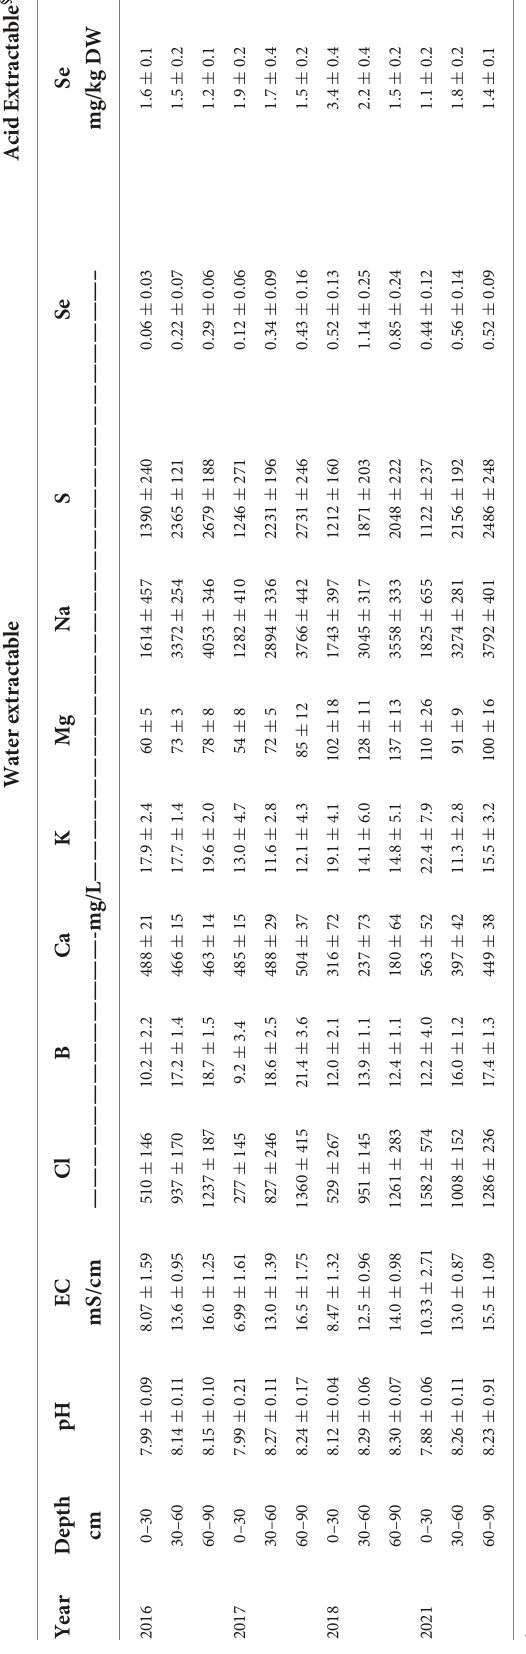
TABLE 2 Total amounts of either low-saline or saline water applied at different rates (Et o %) to microplots for all four years for planting seasons in 2016, 2017, 2018, and 2021,